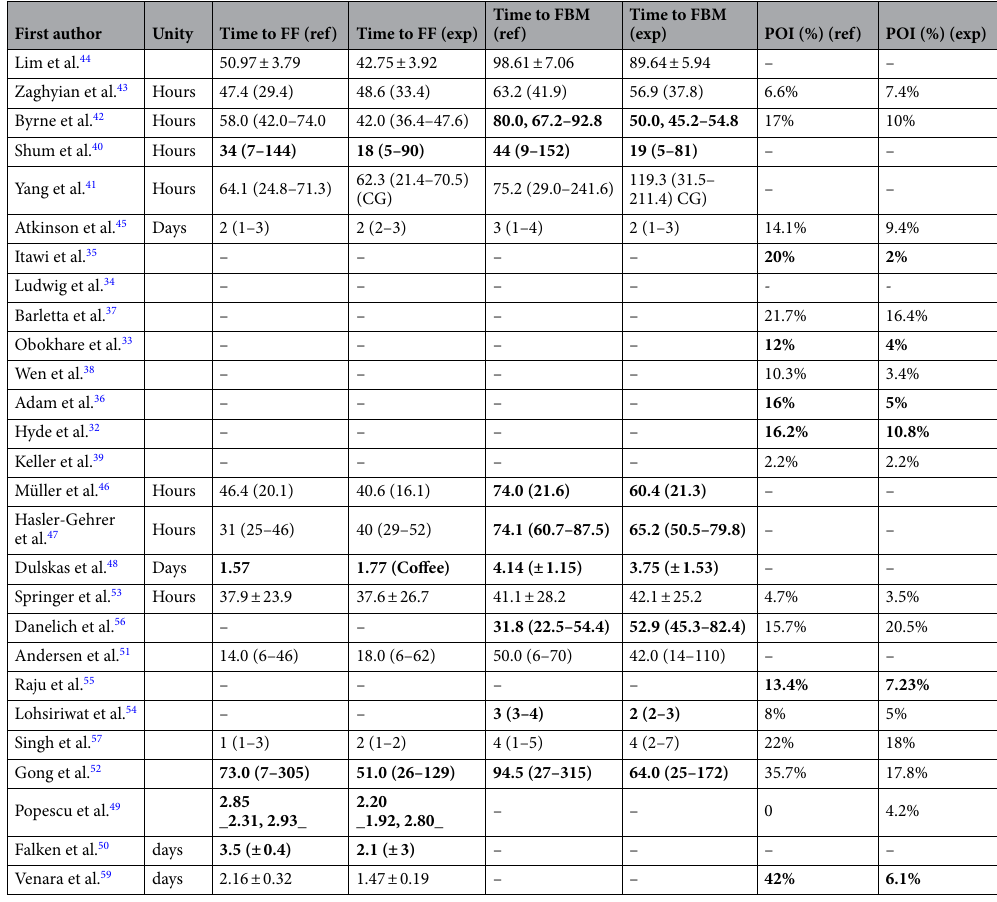
Table 3. Systematic review of the results of the studies assessing preventive treatment for POI. Bold indicate significant difference. FF: time to first flatus, FBM: time to first bowel motion, POI: postoperative ileus, Exp: experimental, Ref : reference, N: none, P: placebo, CG: chewing